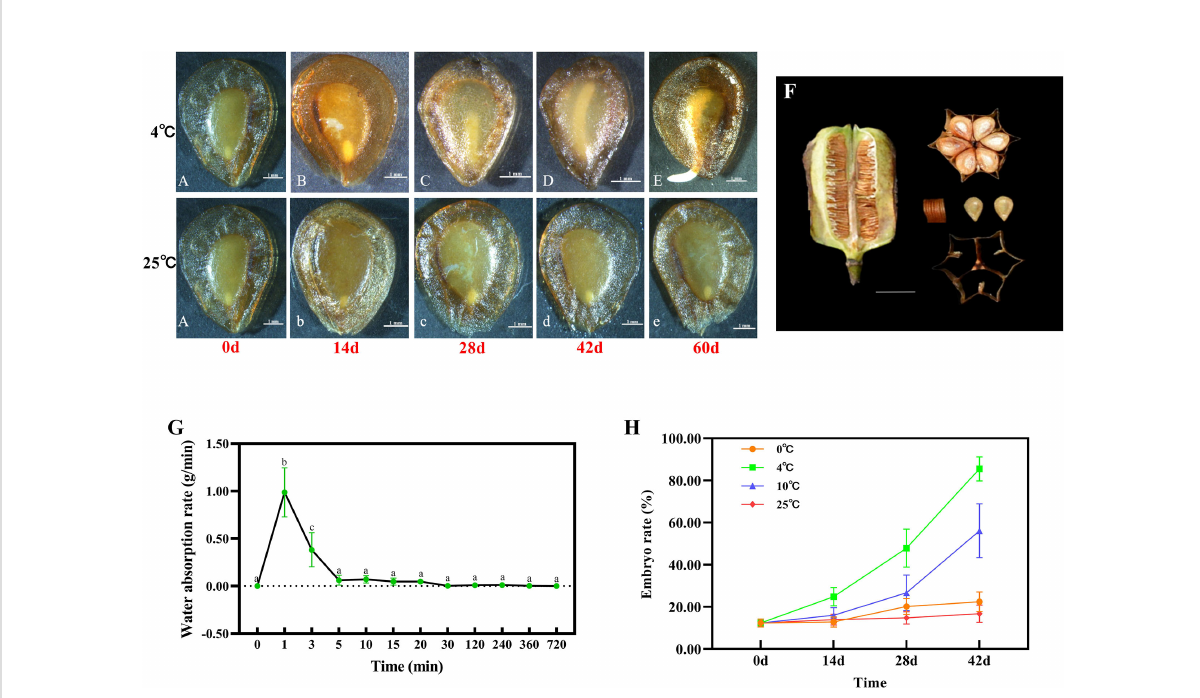
FIGURE 1 Phenotypic observation of the mature seed capsule and seed of F. taipaiensis . Seed embryo growth progression at 4°C (A – E) and 25°C (b – e) . The letters (A – E) , (b – d) and e represent 9 developmental stages of seed development, respectively (listed in Supplementary Table 1). Scale bar=1 mm. (F) Morphological and anatomical structure of mature seed capsule. Scale bar =1 cm. (G) The changes of seed water absorption rate. Values for each point were means ± SD (n = 5). Different letters indicate signi fi cant difference (P < 0.05). (H) The changes of embryo growth rate at different strati fi cation temperatures of 0°C, 4°C, 10°C and 25°C. Values for each point were means ± SD (n =